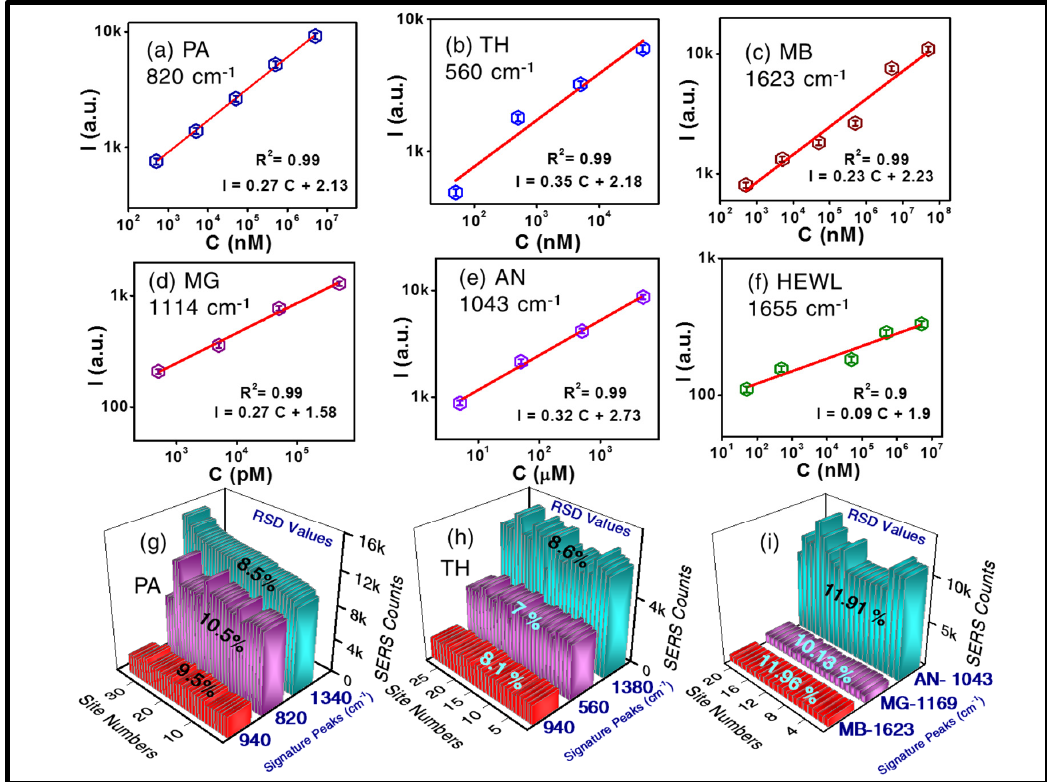
Figure 7. Plots of SERS intensity (I) counts (in arb. units) with respect to analyte concentrations for various molecules ( a ) PA, ( b ) TH, ( c ) MB, ( d ) MG, ( e ) AN, ( f ) HEWL. RSDs were estimated consid- ering 3 major Raman signature peaks of PA (at 820, 940, 1340 cm − 1 ) and are presented in ( g ),